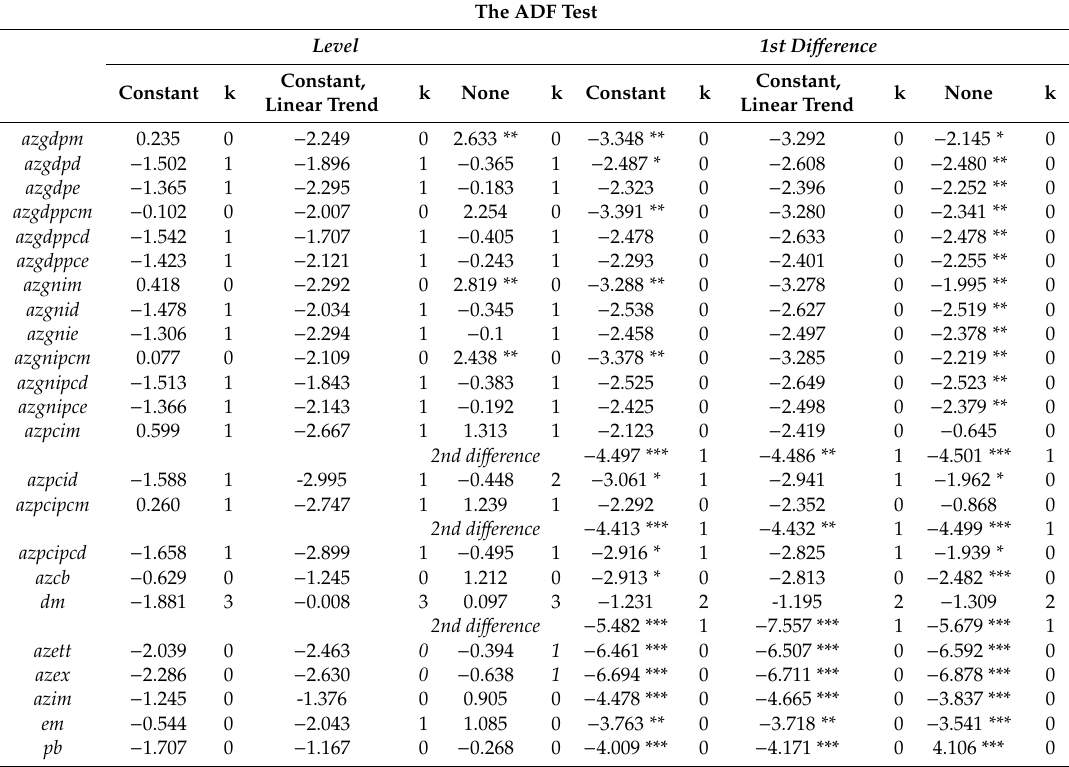
Table A14. AZ. The Unit Root test